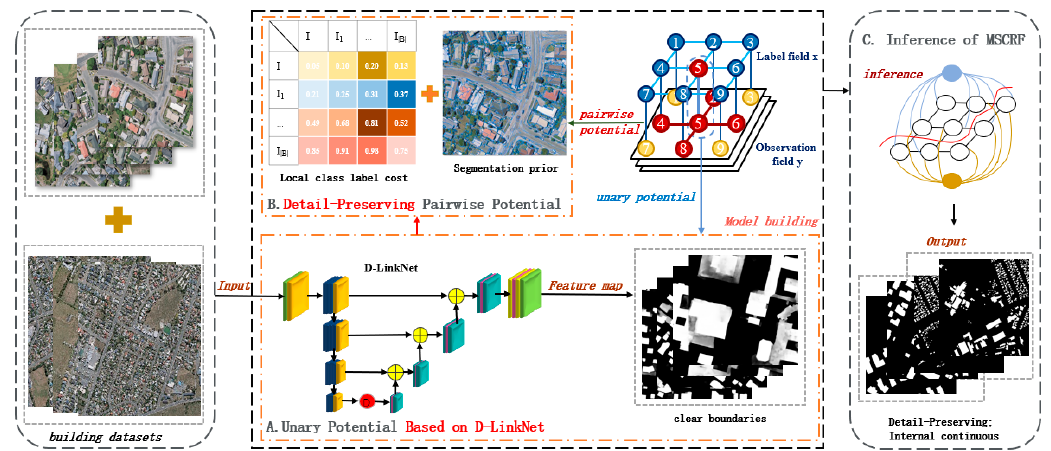
Figure 1. Flow chart of multiscale ‐ aware and segmentation ‐ prior conditional random field.